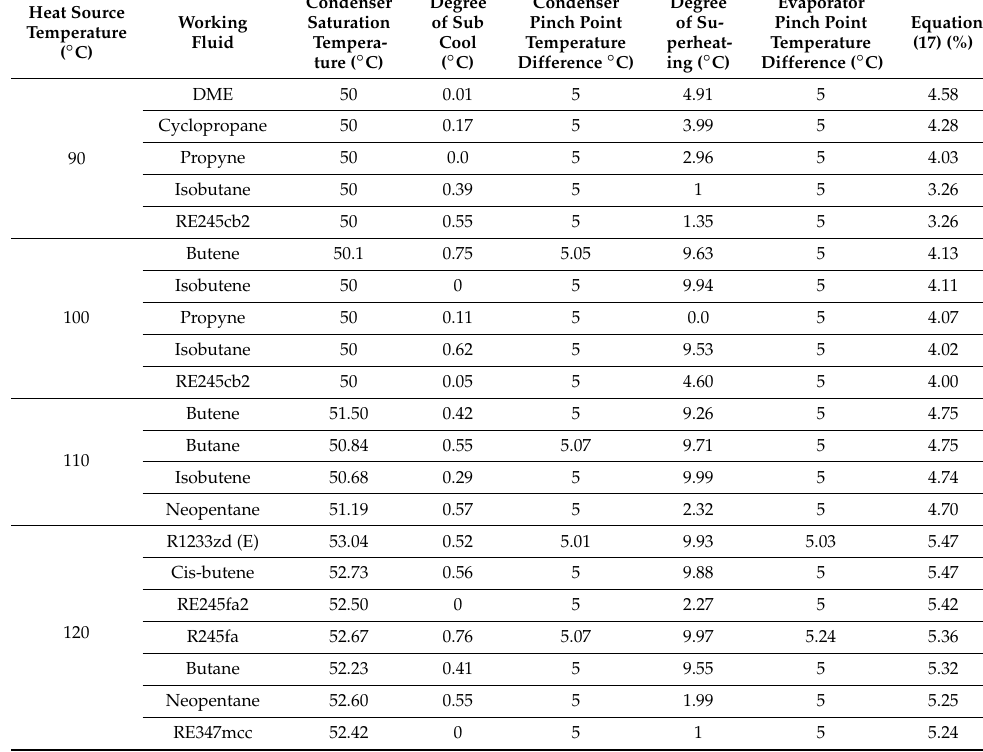
Table 9. Optimization